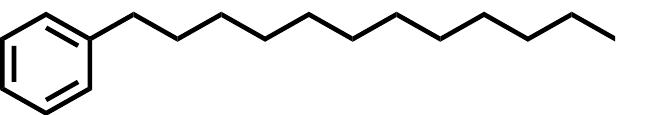
Figure 4. Molecular structure of dodecylbenzene, which reports to the Aro-1 fraction. In order for single aromatic molecules to be detected in the ELSD, they must be heavily substituted with aliphatic side chains or contain naphthenic structures so that they have a sufficient molecular weight and are not evaporated with the solvent and thus not detected (for example, n-C 20 is not detected in the ELSD but n-C 22 is detected). This high degree having a high degree of interaction with the silica gel adsorption sites. This is why this fraction is not completely resolved from the Saturates fraction. Evidence for steric hindrance effects on elution is shown later for the model compounds used for the Aro-2